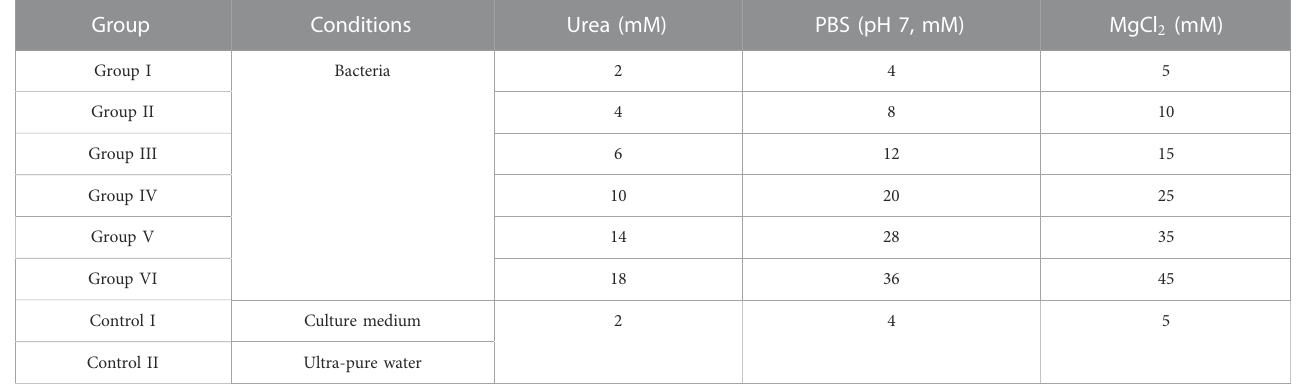
TABLE 2 Conditions and concentrations of different